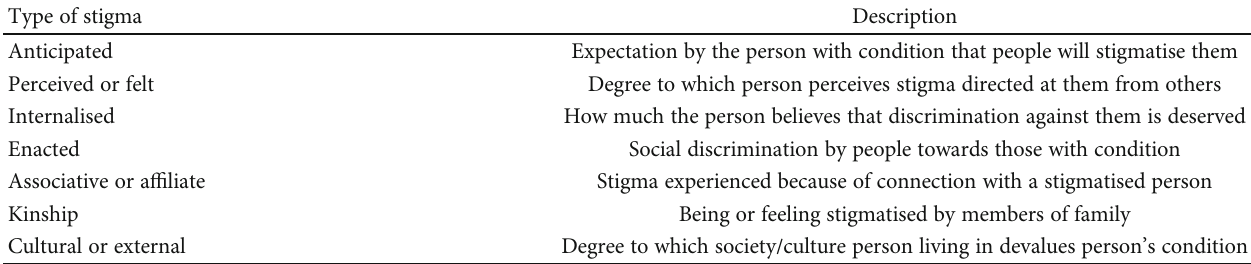
Table 1: Types of stigma (developed from [19, 28,